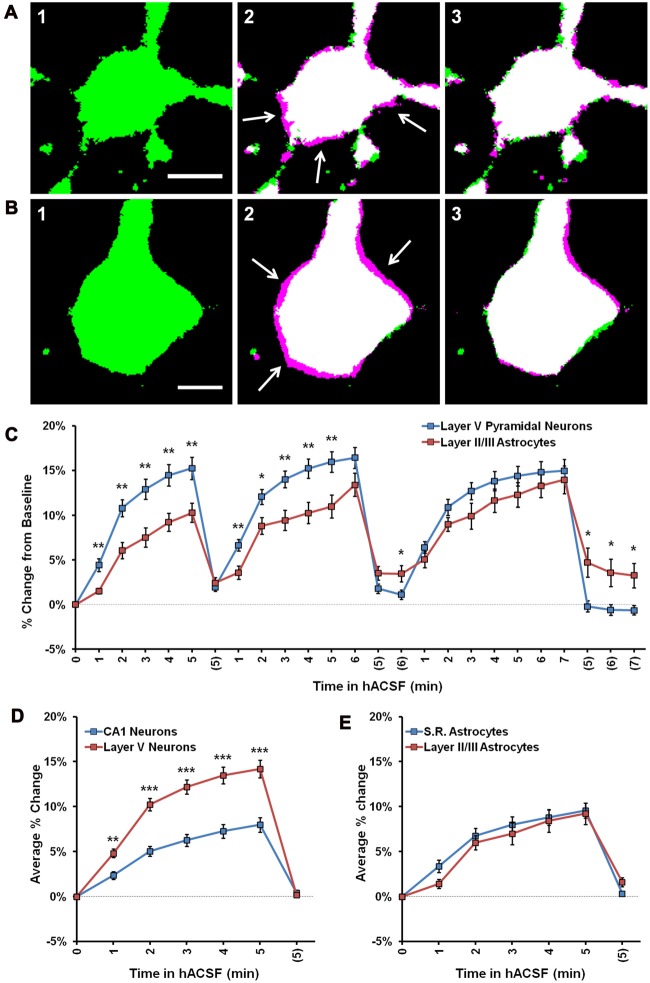
Cortical neurons swell significantly more than cortical astrocytes in 40% hACSF. (A) Representative thresholded image of an astrocyte from cortical layer II/III at baseline (A1), overlaid with an image after 5 min in antagonist-free 40% hACSF (A2) and after 5 min of return to standard ACSF (A3). (B) Representative pyramidal neuron from cortical layer V at baseline (B1), overlaid with 5 min antagonist-free 40% hACSF (B2) and 5 min standard ACSF wash (B3) time point images, as in (A). Magenta highlights surrounding the cell border in (A2) and (B2), indicated by white arrows, reflect increases in cell volume over baseline. Scale bars, 5 μm. (C) Percent change from baseline quantified for cortical (Layer V) neurons and cortical (layer II/III) astrocytes. Note that cortical neurons swell significantly more than astrocytes during the first two applications of hACSF. (D) Comparisons of average percent change over the three hACSF applications reveal that cortical neurons swell to approximately twice the size of hippocampal neurons in hACSF, while cortical astrocytes (E) show similar responses as hippocampal astrocytes. *p < 0.05, **p < 0.01, ***p < 0.001, layer V neurons vs.: layer II/III astrocytes (C) or CA1 neurons (D).